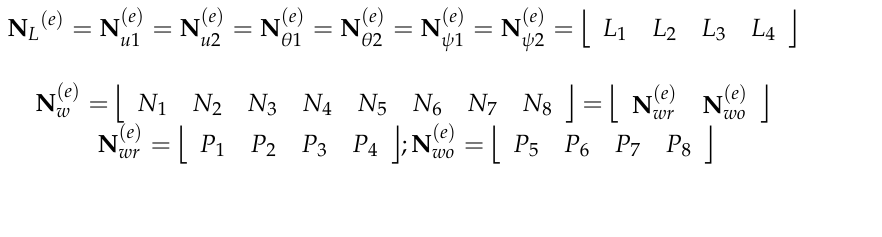
Table 1: It is an RZT4 plate element for the six kinematic variables ( u 1 , u 2 , θ 1 , θ 2 , ψ 1 , ψ 2 ) and an RZT8 plate element for the transverse displacement, w . Therefore, the shape function matrices for the RZT8v element read (see Table